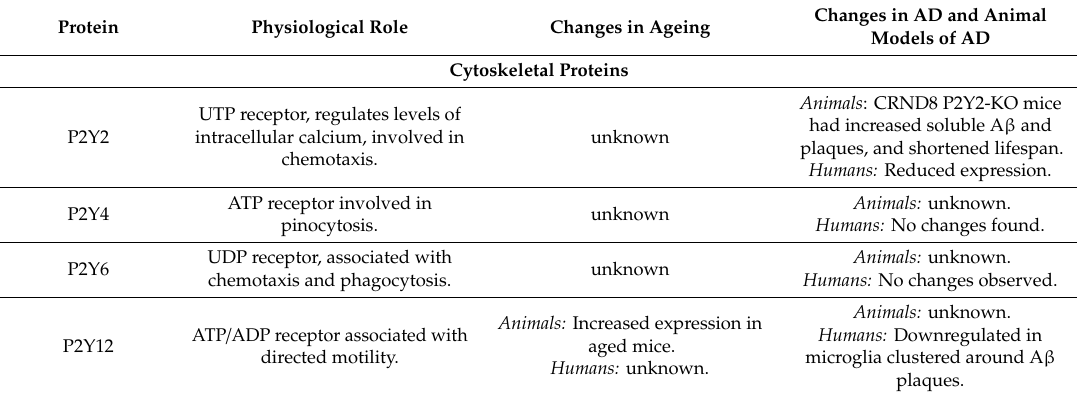
Protein Physiological Role Changes in Ageing